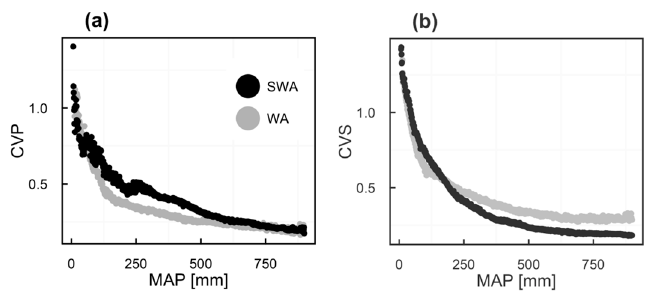
Figure 3. Interannual variability of annual rainfall and rainy season length for the two regions of South West Africa (SWA) and West Africa (WA). ( a ) The coefficient of variation of annual rainfall (CVP), and ( b ) the interannual coefficient of variation of wet season length (CVS) are plotted as a function of mean annual precipitation (MAP) for both study regions.